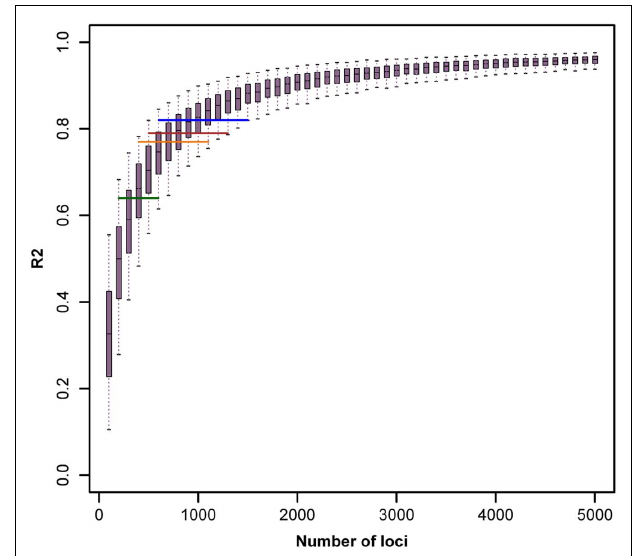
FIGURE 7 | Boxplots of R 2 values from the regression of chromosome length on number of loci within it, for different number of total simulated loci. Horizontal lines depict the 95% quantile bounds for the number of loci inferred from R 2 values (method 3, without BTA14) for milk yield (blue), protein percentage (orange), fat percentage (green), and somatic cell score